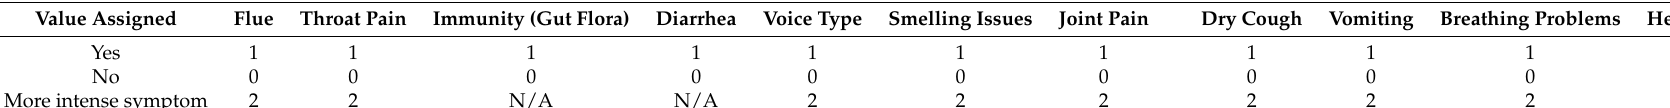
Table 2. Representation of dataset.